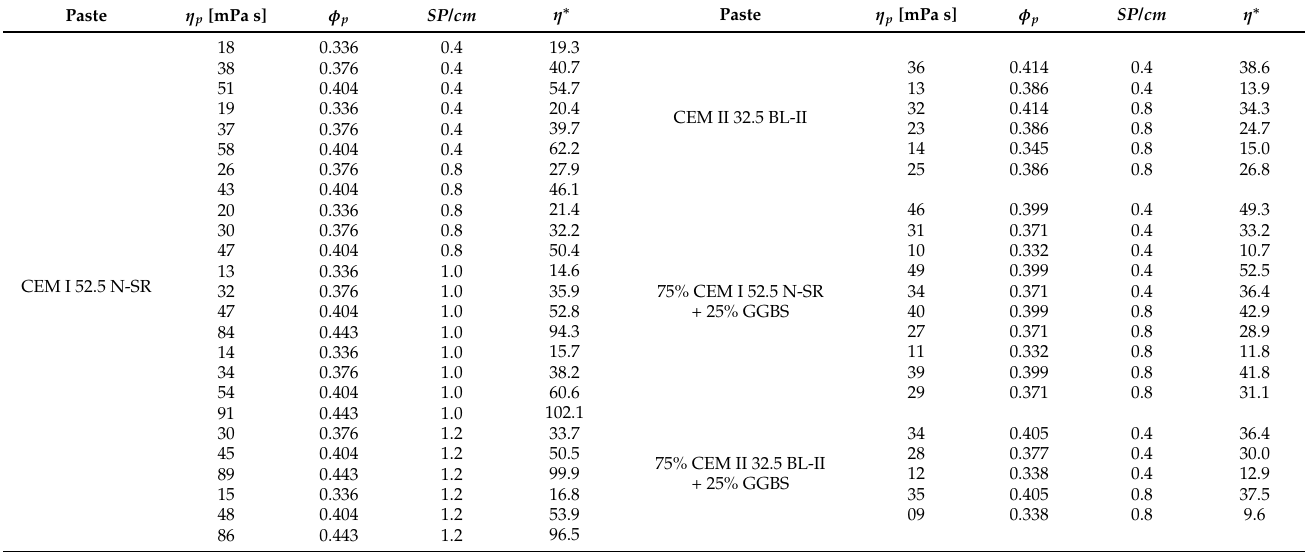
Table A1. Experimental dynamic viscosities of the cement pastes.